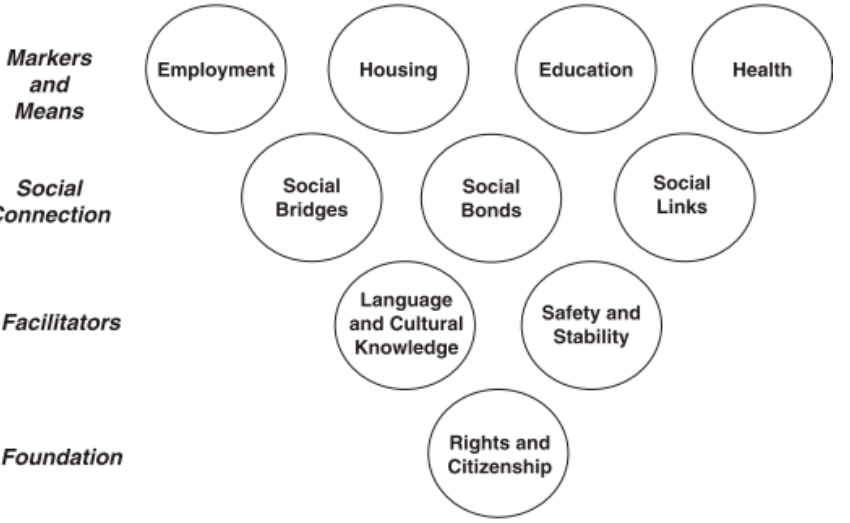
Figure 1. A conceptual framework defining core domains of integration. Reprinted from ref. [21].